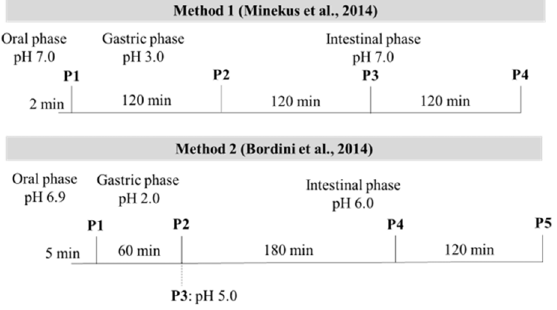
Figure 1. pH and digestion time of in vitro method 1 [15] and 2 [17] at end of oral phase (M1-P1 and M2-P1), end of gastric phase (M1-P2 and M2-P2), and before (M2-P3), half (M1-P3 and M2-P4), and end of intestinal phase (M1-P4 and M2-P5).